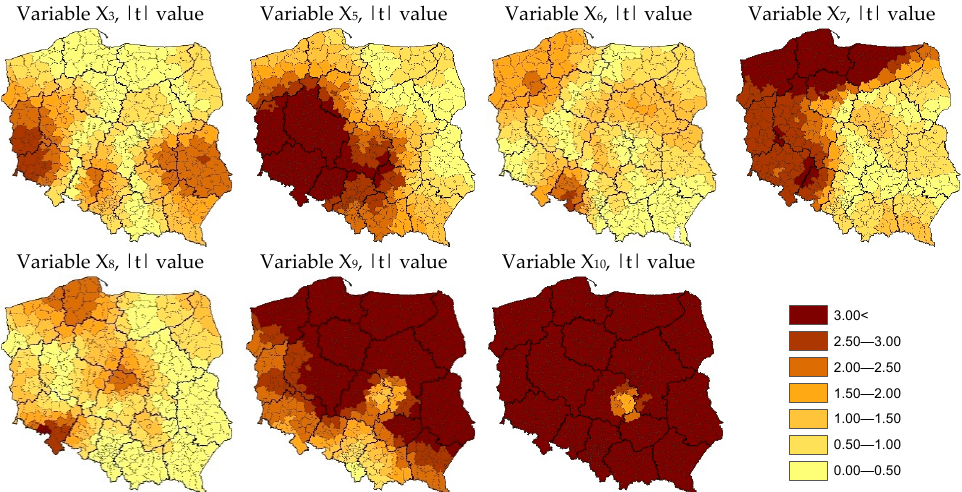
Figure 5. Spatial distribution of the parameters at local variables in the MGWR2 model (standardised variable values were used for estimation). Source: own research.